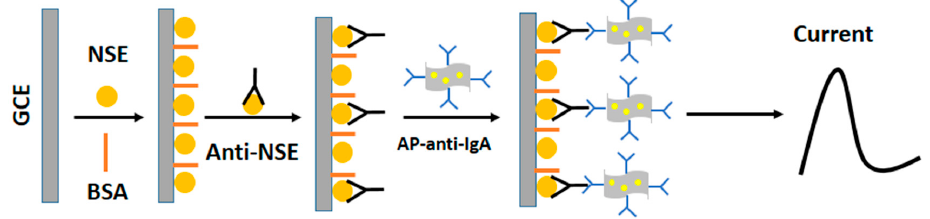
Scheme 1. Schematic representation of the designed electrochemical immunosensor for neuron- specific enolase (NSE) detection. BSA: bovine serum albumin.